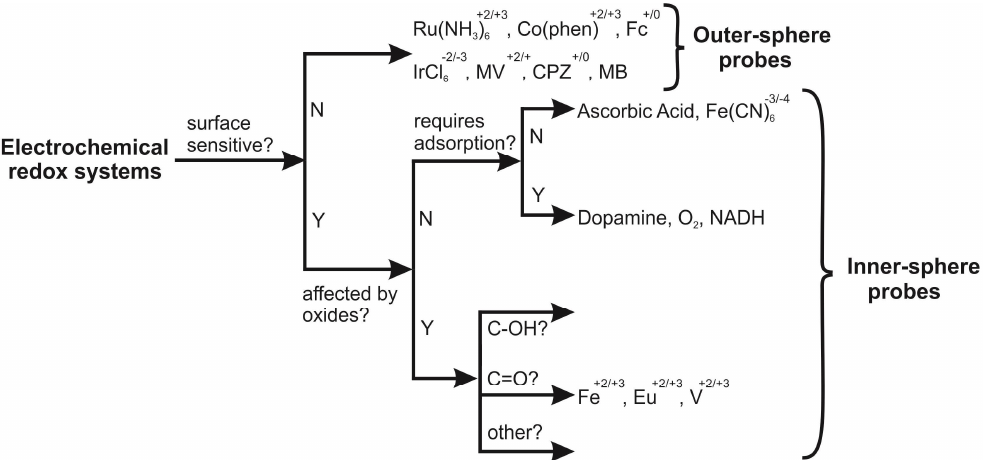
Figure 2. Classification of redox systems by Mcreery et al. [39] according to their kinetic sensitivity to particular surface modifications upon carbon electrodes. The figure has been adapted by the authors of this paper to clearly show outer- and inner-sphere probes. Fc: ferrocene, MV: methyl viologen, CPZ: chlorpromazine, and MB: methylene blue.